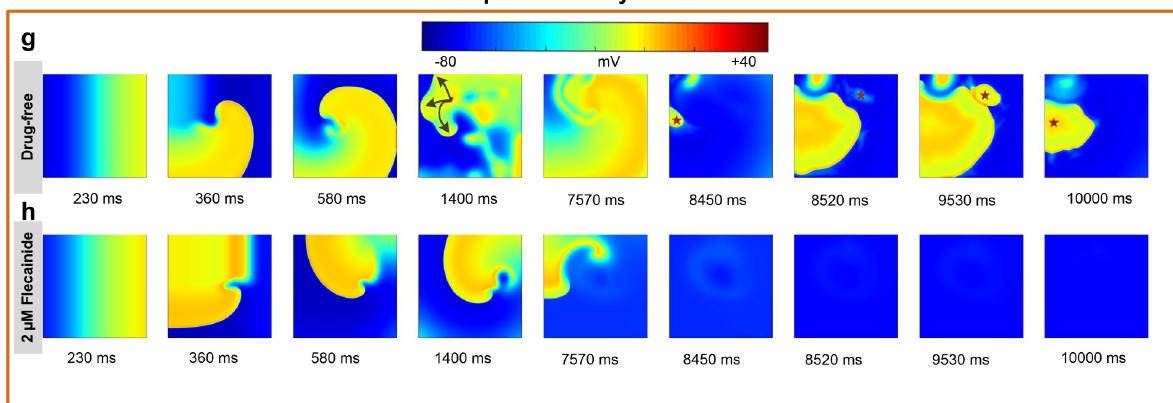
Fig 5. Simulated spontaneous ectopic activity and re-entry. a, A 500 × 500 square tissue model includes normal atrial myocytes, Pitx2-4 remodelled LA cells, fibrosis, and gap junctions. Simulated spontaneous ectopic activity in the tissue model with 20% Pitx2-4 cells ( b ), with further increased Pitx2-4 cells ( c ), with enhanced cell-to-cell uncoupling ( d ), with increased fibrosis ( e ), and with increased cell-to-cell uncoupling and fibrosis ( f ). Re- entrant waves in the drug-free Pitx2-4 settings ( g ) and in the presence of 2 μ M flecainide ( h ). Note: For the #1 scenario, the diffusion coefficient (D) was set to be 100% and the ratio of normal cells, Pitx2-4 cells and fibrosis was set to be 80:20:0. For the #2 scenario, the number of Pitx2-4 cells was increased to 40% and thereby the ratio of different cell types was 40:60:0. And D was set to be 100%. For the #3 scenario, D was reduced to 30% to model cell-to-cell uncoupling and the ratio of different cell types was set to be 80:20:0. For the #4 scenario, fibrosis was increased to 2% and thereby the ratio of different cell types was 78:20:2. And D was set to be 100%. For the #5 scenario, fibrosis was increased to 2% and D was reduced to 30%. And the ratio of different cell types was